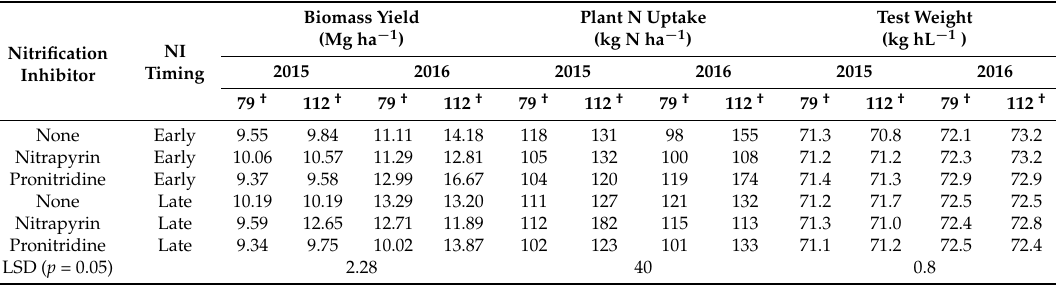
Table 5. The effect of urea ammonium nitrate application rates, nitrification inhibitors, and timing of the nitrification inhibitor on tissue biomass yields, N uptake, and grain test weight. Data were combined over factors in the absence of significant